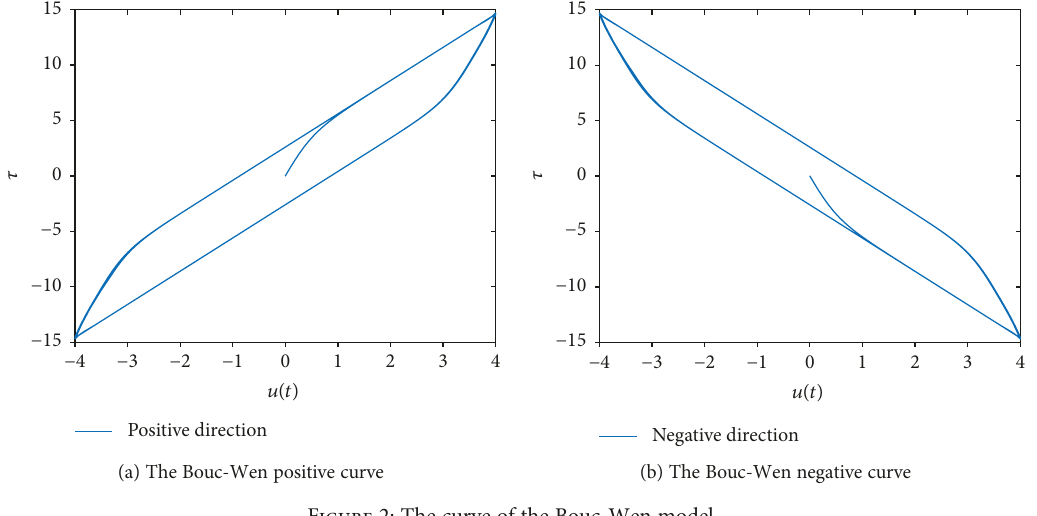
Figure 2: The curve of the Bouc-Wen